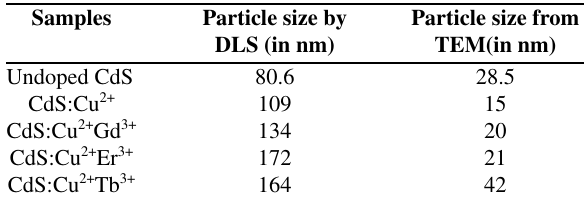
Table 2. Particle size obtained from DLS technique and